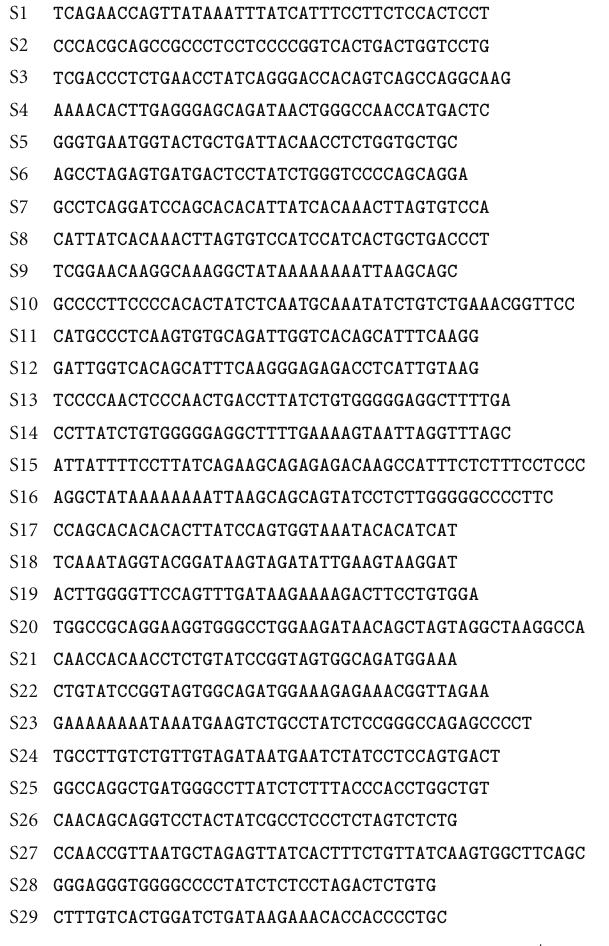
-end trimmed to the maximum length 50 ′